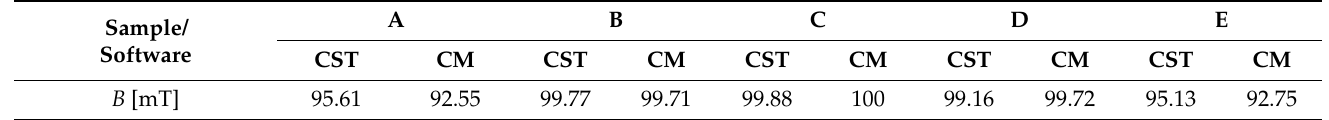
Table 1. The homogeneity of B-field at evaluation points in CST Studio and COMSOL in exposure coil. Sample/